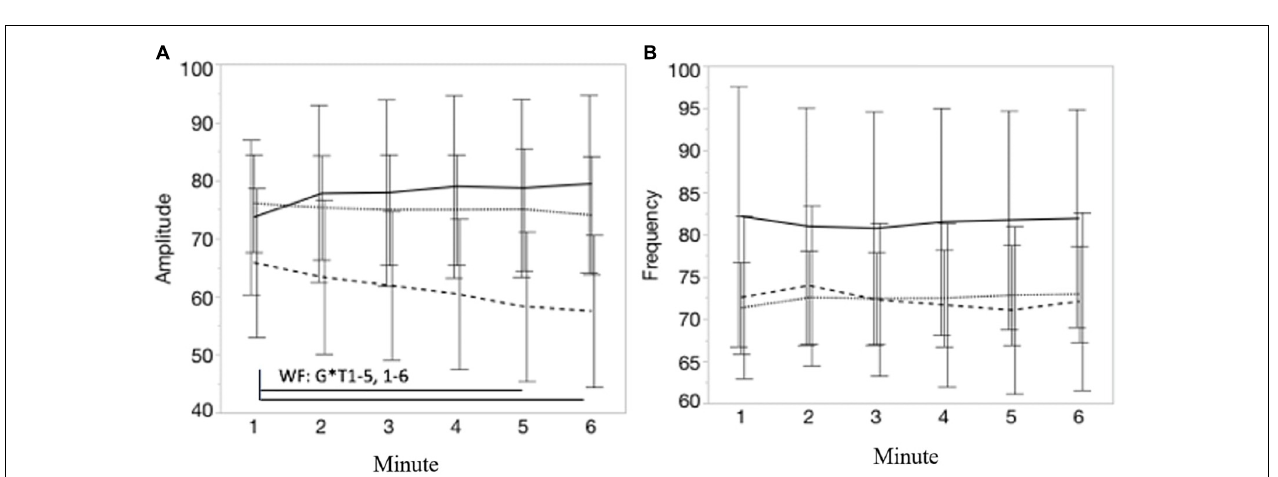
FIGURE 6 | (A,B) Represents, respectively, the course of the movement amplitude and movement frequency during each minute of the 6MCT. Error bars represents 95% confidence intervals. Stripe pattern line represents persons with MS with walking fatigability (WF), dotted line represents persons with MS without walking fatigability (NWF) and solid line represents healthy controls (HC). *WF: G*T1–5, 1–6: significant interaction effect of group*time: pwMS with WF decreased their movement amplitude significantly from minute 1 to 5 ( p < 0.01) and minute 6 ( p < 0.00).